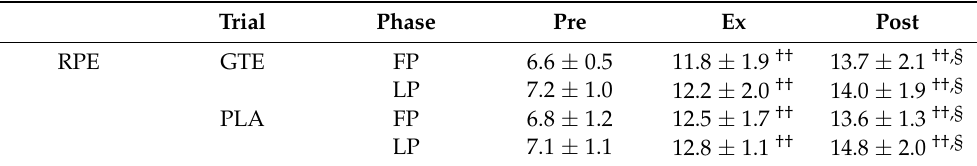
Table 3. RPE concentrations before, during, and after